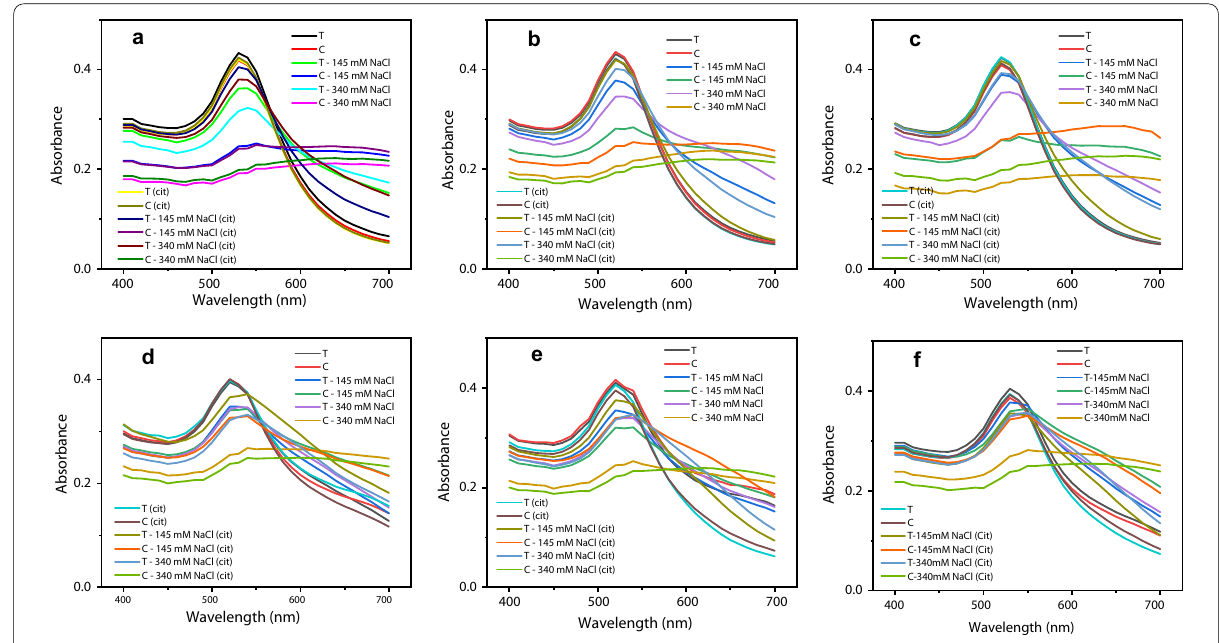
Fig. 2 The UV–visible spectra of the Au NPs added to the oligonucleotides subjected to different hybridization conditions in terms of flash heating: a , d no flash heating, b , e 95 °C for 30 s, and c , f 95 °C for 120 s. The top and bottom row experiments were performed with 1.5 and 3.0 μM concentrations of the oligonucleotides, respectively. The respective symbols T and C represent target and control, while the experiments performed with the addition of citrate buffer were coded with (cit). The final concentrations of the NaCl were also mentioned alongside the sample